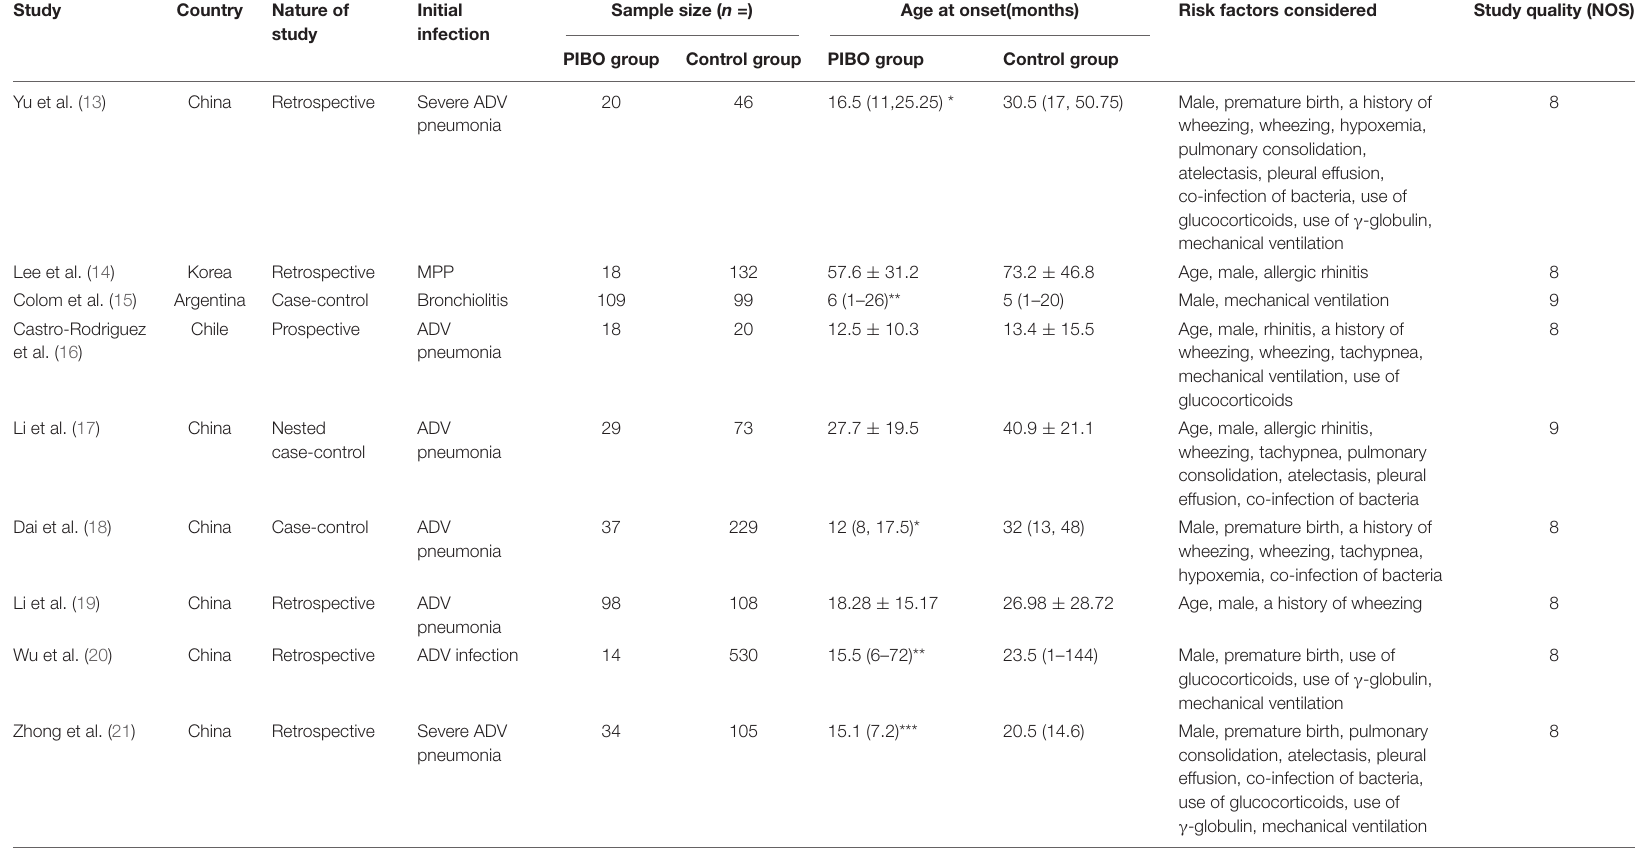
TABLE 1 | Summary of studies included in the meta-analysis.